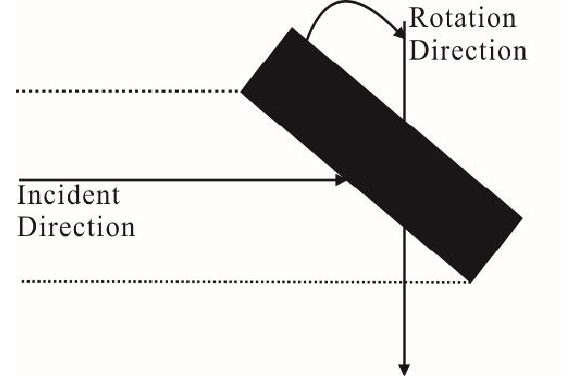
Figure 2. Principle of Pendulum Scanning Device